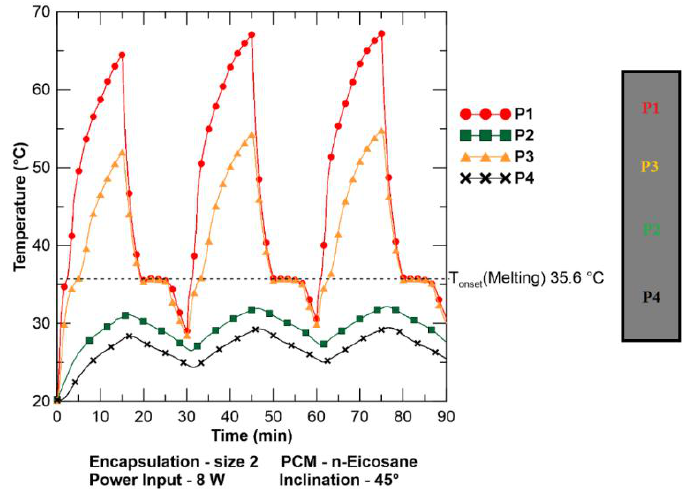
Figure 3. Melting curves of n- eicosane for Size 2 TES unit at 45° inclination and 8 W power